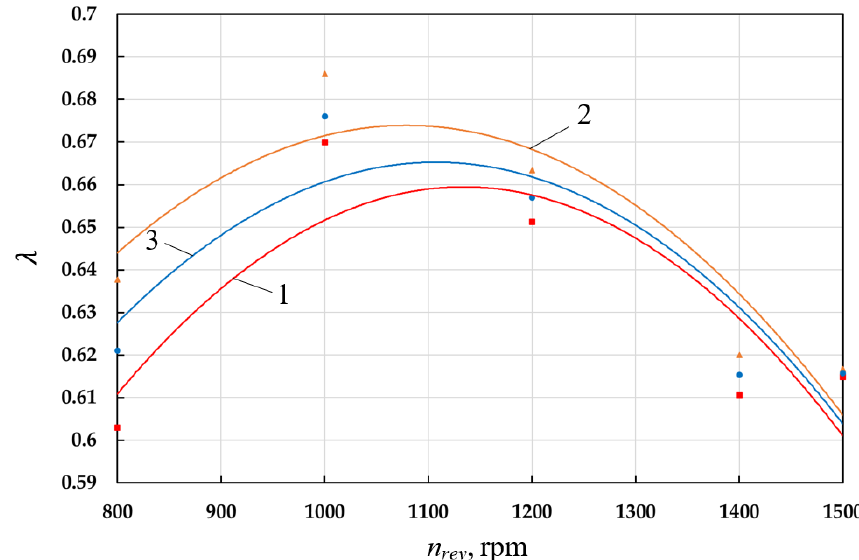
Figure 14. Dependence of the supply coefficient of the left (1 — 𝜆 1 ) and right (2 — 𝜆 2 ) cylinders and